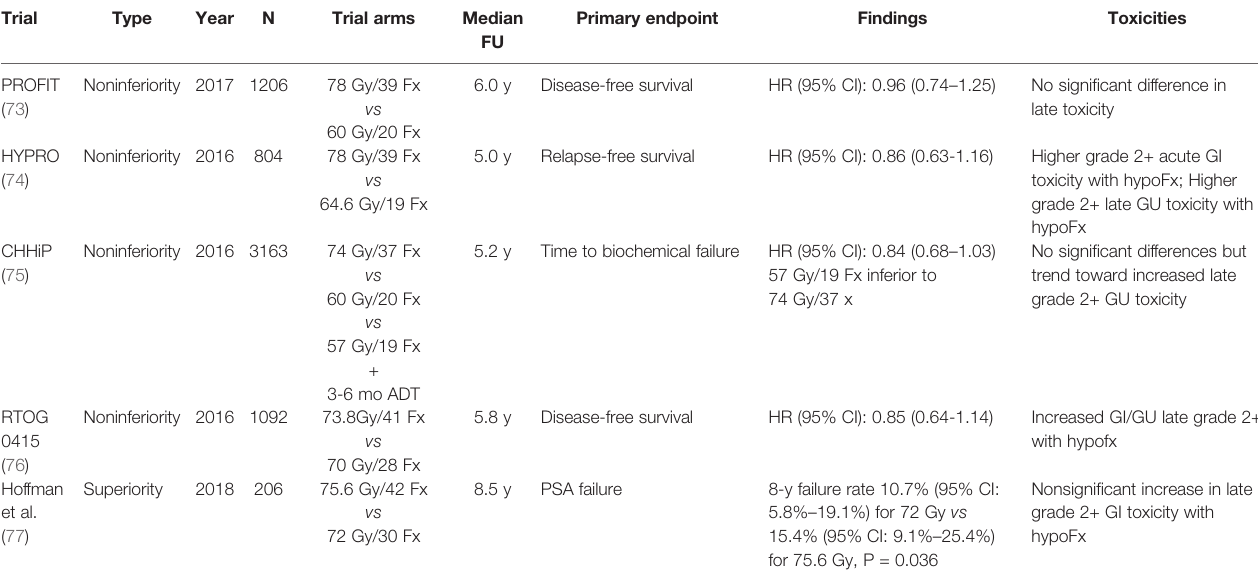
TABLE 4 | Moderate hypofractionation trials for prostate cancer.